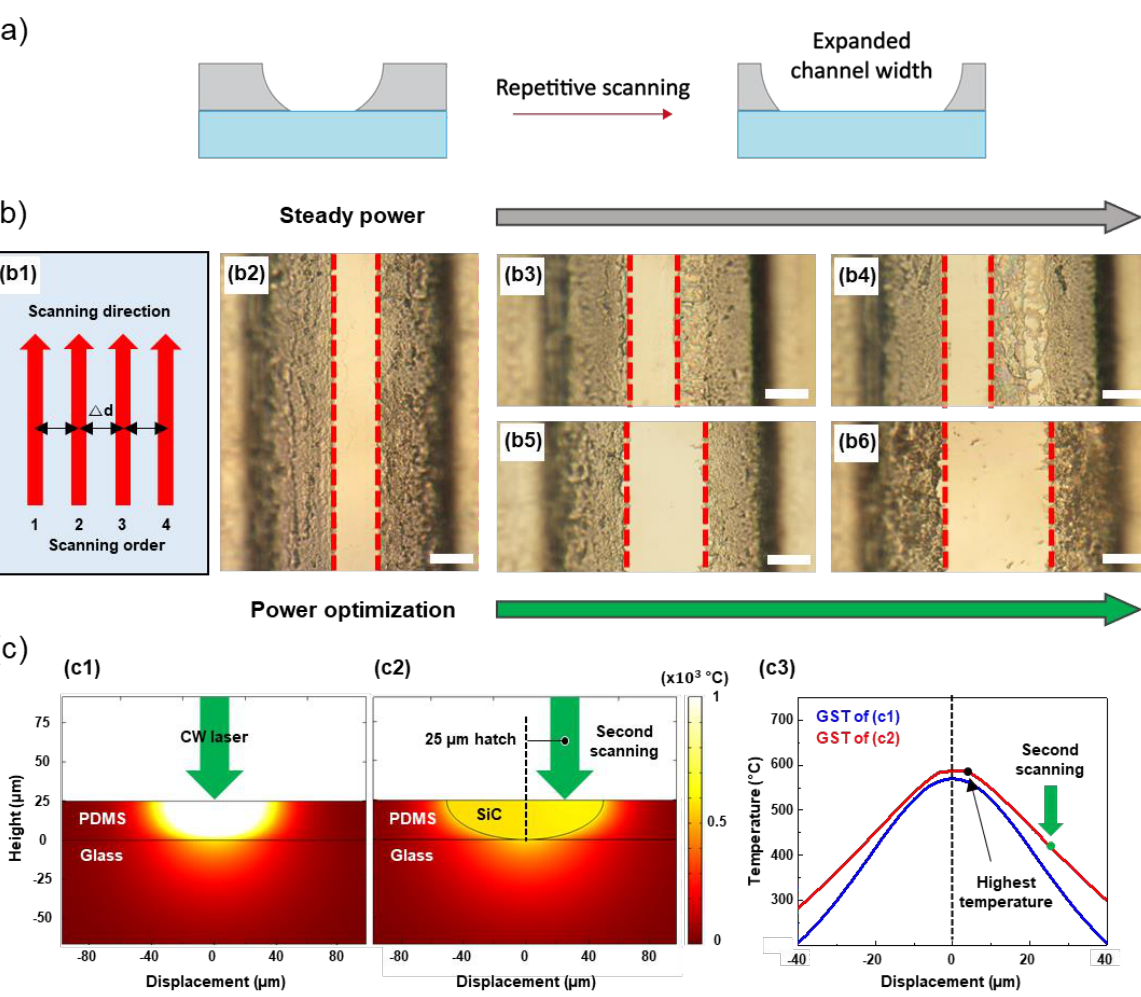
Figure 3. ( a ) Schematics representing cross − section image of the expanded channel, ( b ) Channel expanding order and direction shown as ( b1 ), and optical microscopy images of ( b2 ) for two times, ( b3 ) and ( b5 ) for three times, ( b4 ) and ( b6 ) for four times consecutively scanned samples. scale bar: 20 µm. ( c ) COMSOL simulations for thermal conduction of PDMS layer and SiC given by laser power, ( c1 ) shows the result of laser irradiation on the PDMS surface, ( c2 ) shows result of laser irradiation on the SiC surface with 25 µm hatched point, and ( c3 ) graph shows glass surface temperatures (GST) for both cases of ( c1 ) and ( c2 ).